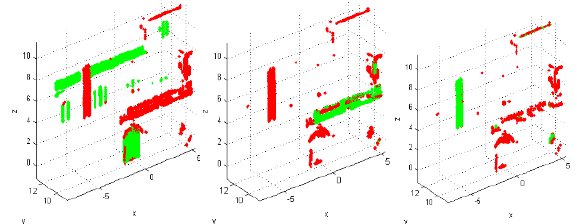
Figure 6. Other primary planes parallel to the main primary plane (green).